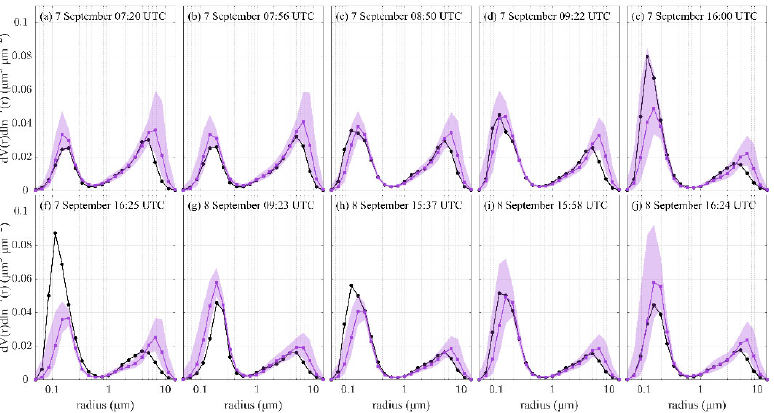
Figure 3. Particle volume size distributions (VSD) derived using GRASP (purple line + squares) and AERONET (black line + dots) retrievals for the 10 selected BB cases. Corresponding errors provided by GRASP are shown by shaded areas.